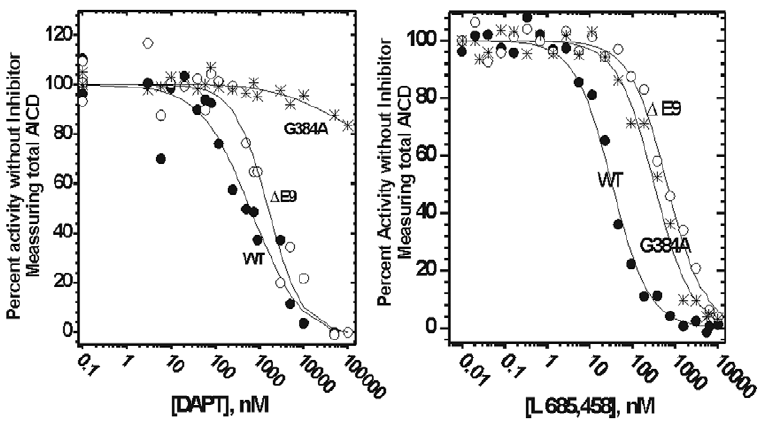
Figure 9. Inhibition of WT presenilin 1 and FAD mutants by DAPT and L-685,458. CHAPSO enriched c -secretase membranes carrying WT presenilin 1 or FAD mutations D E9 and G384A have been prepared and analyzed in parallel with all conditions identical. The dose response curves for DAPT [71] and L-685,458 [15] were measured by following total AICD production using western-blots with a M2 antiflag antibody as shown in Fig. 3. The results were analyzed using nonlinear regression and the equation 3 (methods). The best fit values and the corresponding statistics are given in